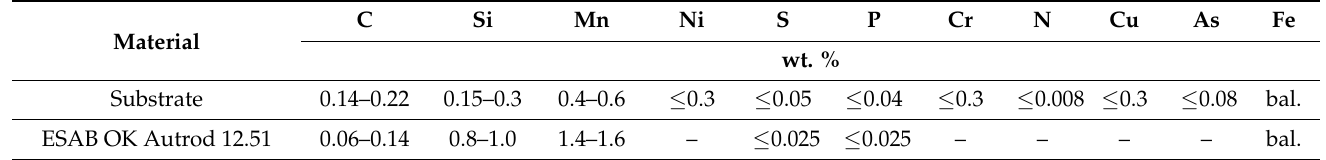
Table 2. Substrate and filler metal chemical